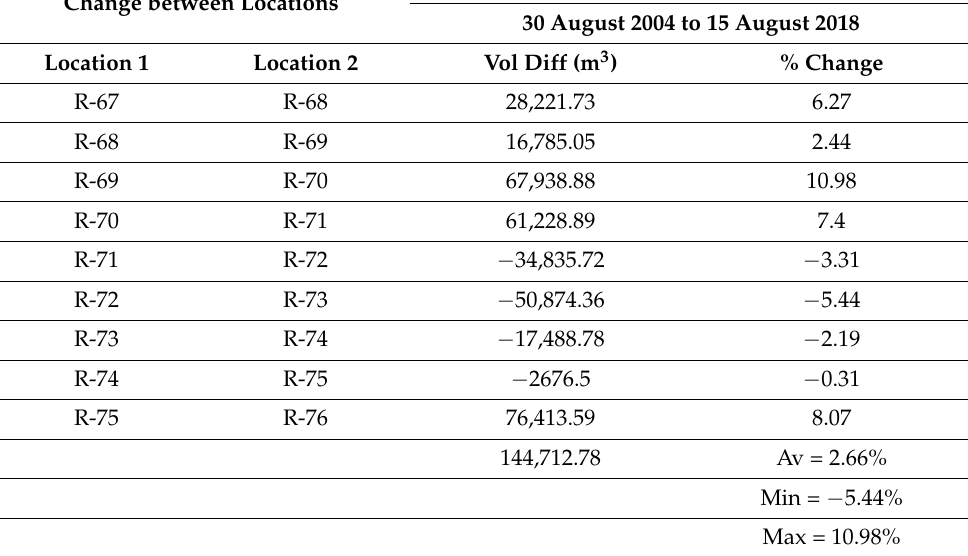
Table 1. Sediment volume calculations between R-monuments in the northern portion of North Captiva Island for 2004 to 2018. Beach volume change is estimated using a master profile (MP) kept at 2 m below NAVD88